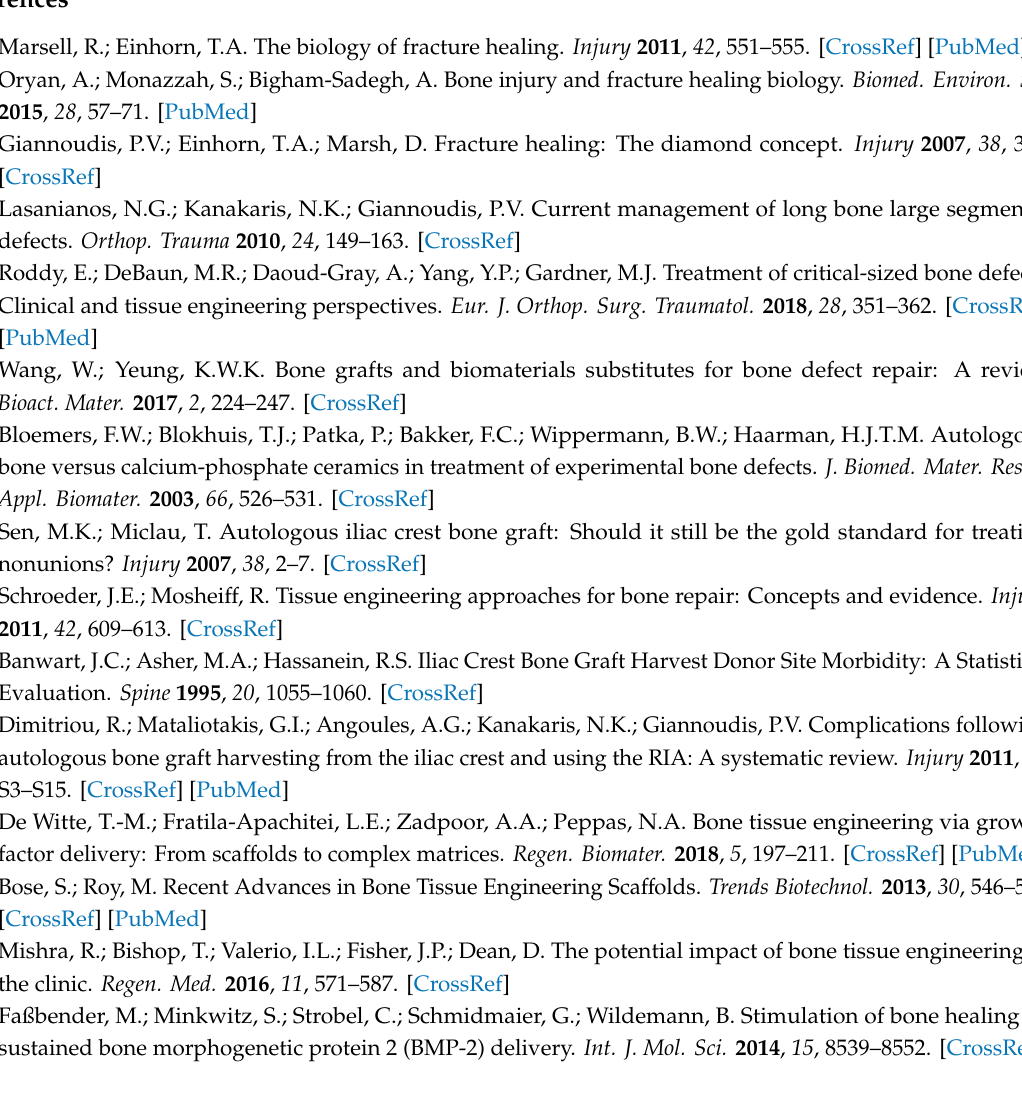
Figure S1: Strain uncertainties analysis; Figure S2: Random errors analysis; Figure S3: Correlations between mechanical and microstructural parameters; Figure S4: Thickness and mineralization di ff erences between regions highly and lowly